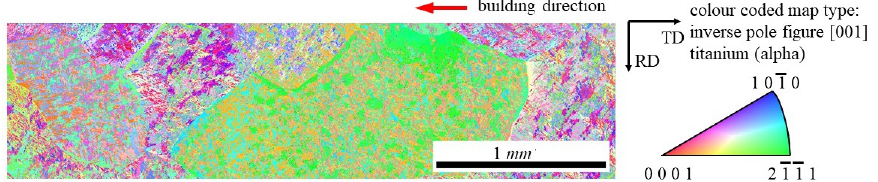
Figure 4. Crystal orientation map ([001] = ND, [010] = TD, [100] = RD) of WAAM-fabricated Ti-6Al-4V, according to the local coordinate system for the EBSD analysis; the colour coding shows that the α lamellae are oriented differently within the respective domains, resulting in low micro-texture sharpness; calculation of Taylor factors based on at least 78,000 grains; aspect ratio d min / d maj of the different grains is between 0.31 ± 0.16 and 0.35 ± 0.16, the long side is between d maj = 16.4 ± 4.7 µ m and d maj = 20.7 ± 5.8 µ m, the short side is between d min = 4.1 ± 1.0 µ m and d min = 5.5 ± 1.1 µ m. The inverse [ 001 ] pole figure (transverse direction) shows the occurrence of axial intensities at (cid:104) 2110 (cid:105) with a spread angle to (cid:104) 0001 (cid:105) as well as (cid:104) 1010 (cid:105) and (cid:104) 2125 (cid:105) ; see Figure 5. = 4.19 ± 0.59. The Taylor factor is M [ 001 ]